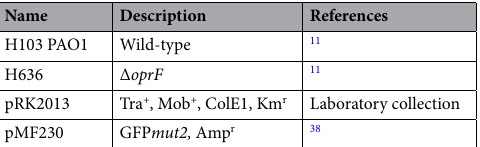
Table 1. Bacterial strains and plasmids used in the